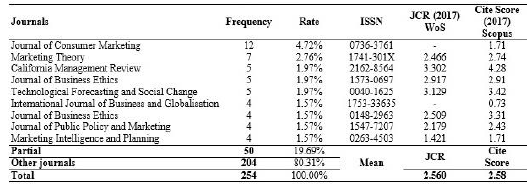
Table 2: Journals with the Most Articles published in the Scopus and Web of Science Databases